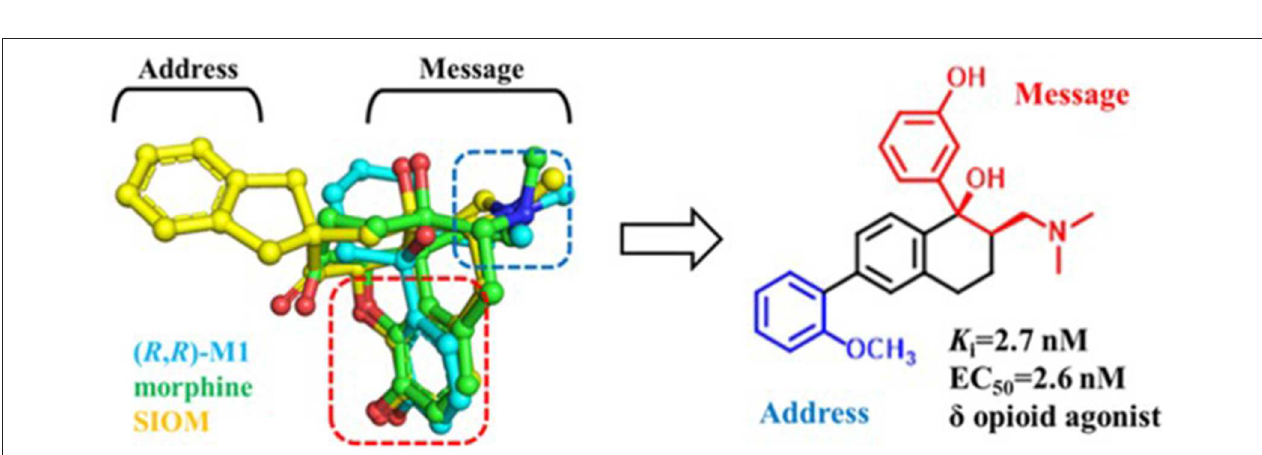
FIGURE 4 | (A) Highly selective and potent κ opioid agonist SLL-039 (compound 4 ) and its address part. (B) Putative binding mode of SLL-039 (in green) in the κ opioid receptor binding site. The benzamide phenyl group of SLL-039 was fit into a tight hydrophobic subpocket composed of Val118 2.63 , Trp124 EL1 , and Glu209 EL2 . Hydrogen bonding interactions are shown by yellow dotted lines.